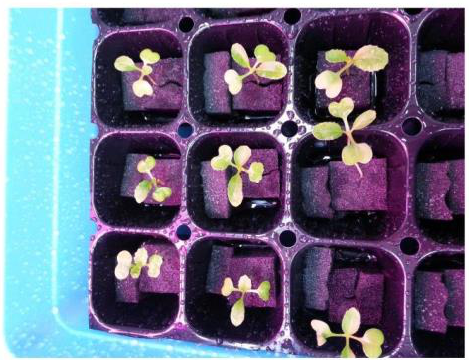
Figure 14. Original image of lettuce seedlings.